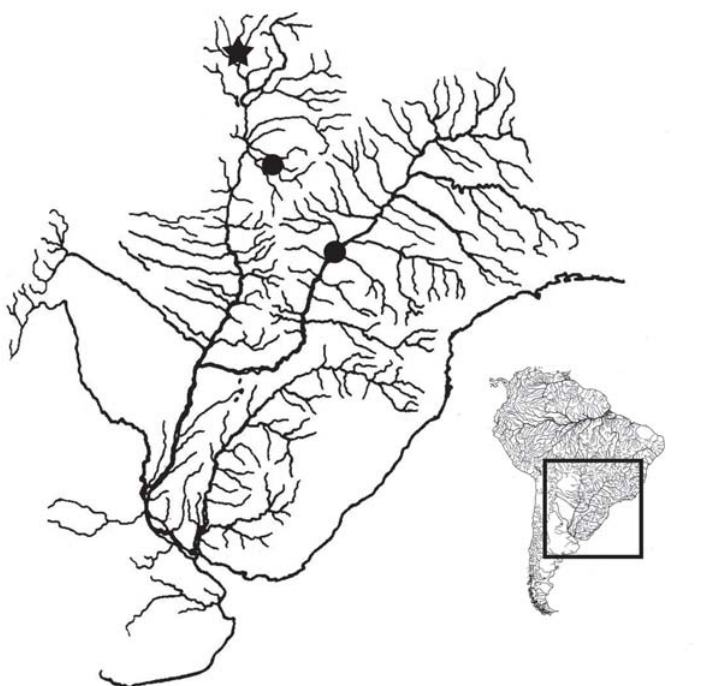
Fig. 3. Map of the rio La Plata basin showing the localities of collection of Moenkhausia forestii , new species. Star represents the type locality.